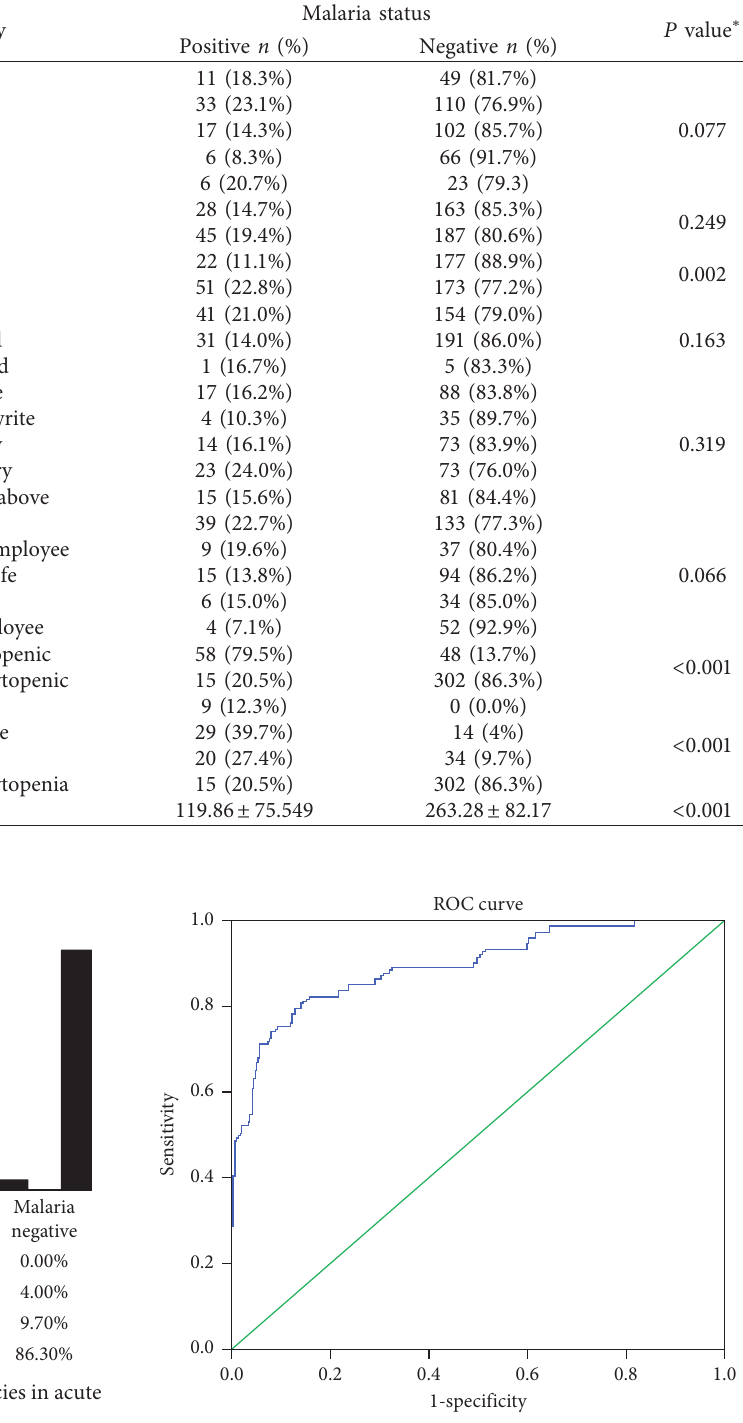
Figure 2: Receiver operating characteristic (ROC) curve for platelet count in acute febrile patients.